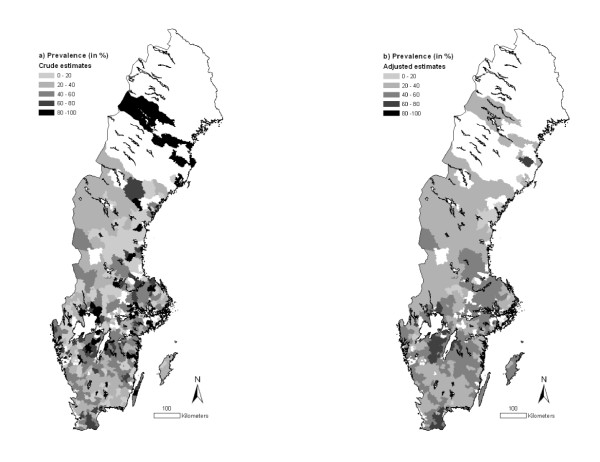
Prevalence of BCV in Swedish beef cattle by three-digit postal code area (2007). The estimates presented are (a) crude or (b) adjusted by empirical Bayes smoothing applying a spatial weight matrix. Information was missing for the white areas. © Lantmäteriverket Gävle 2010. Permission number I 2010/0055.